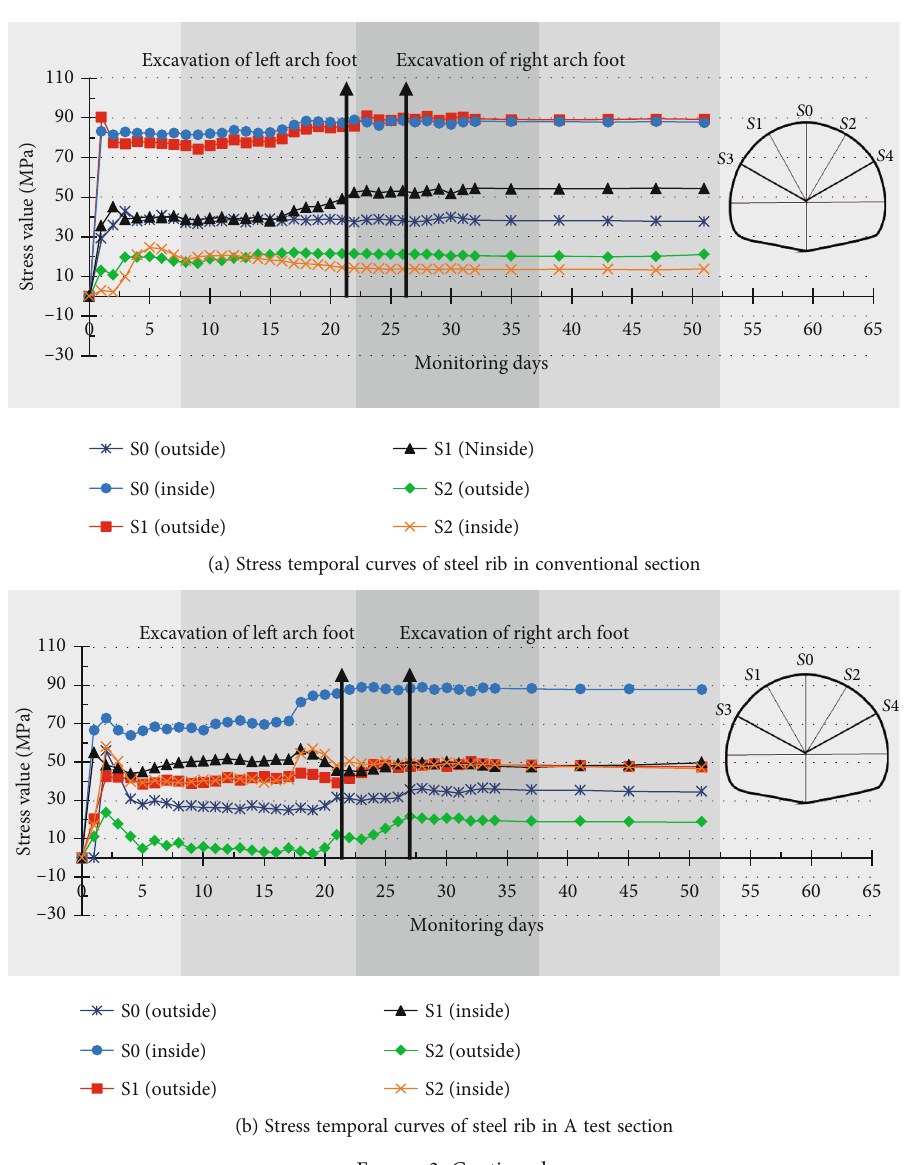
(b) Stress temporal curves of steel rib in A test